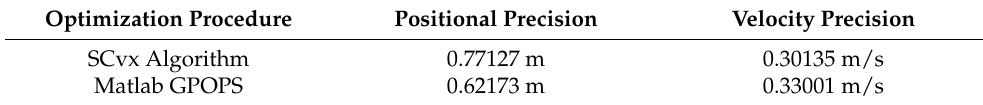
Table 4. Comparison of SCvx algorithm and Matlab GPOPS-II integration precision.